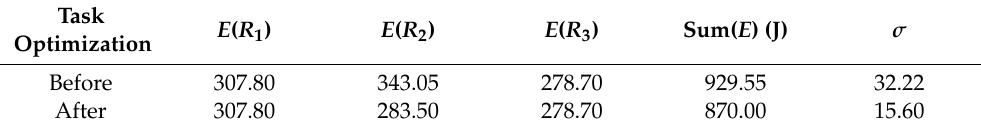
Table 9. Comparison of energy consumption before and after optimization from Experiment